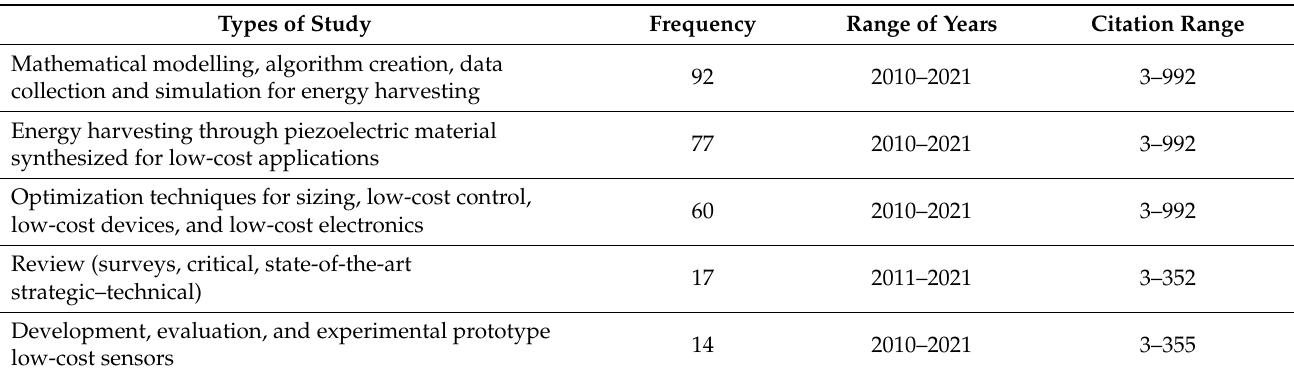
Table 7. Highly cited manuscripts in Scopus database.